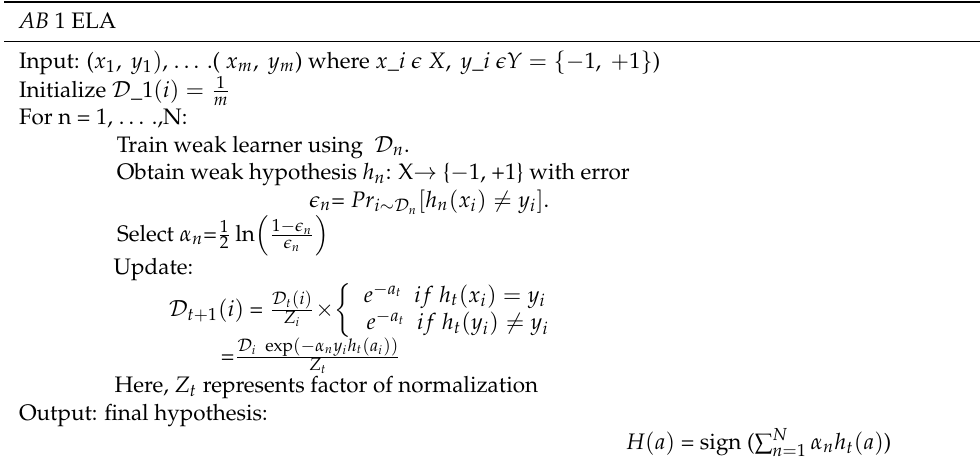
Table 1. Mathematical step-by-step explanation of the working flow of the ensemble learning algorithm (ELA) representing Adaboost (AB) [32].